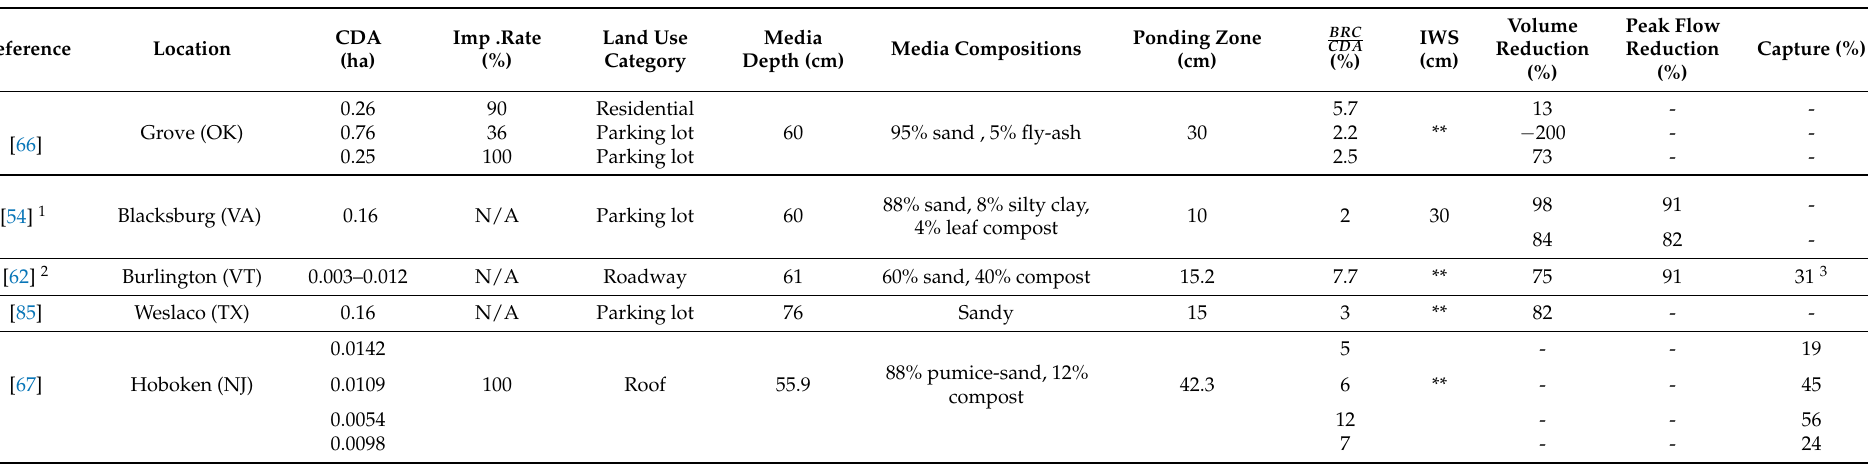
Table 2. The hydrologic performance, volume reduction, peakflow reduction, and capture of the BRC literature studies in the USA. For each study, the site characteristics, including the contribution drainage area (CDA), the imperviousness rate (Imp.Rate), and the land use category, are reported together with the system characteristics, including media depth and composition, ponding zone, fraction between the BRC and contribution drainage areas (BRC/CDA), and the internal water storage